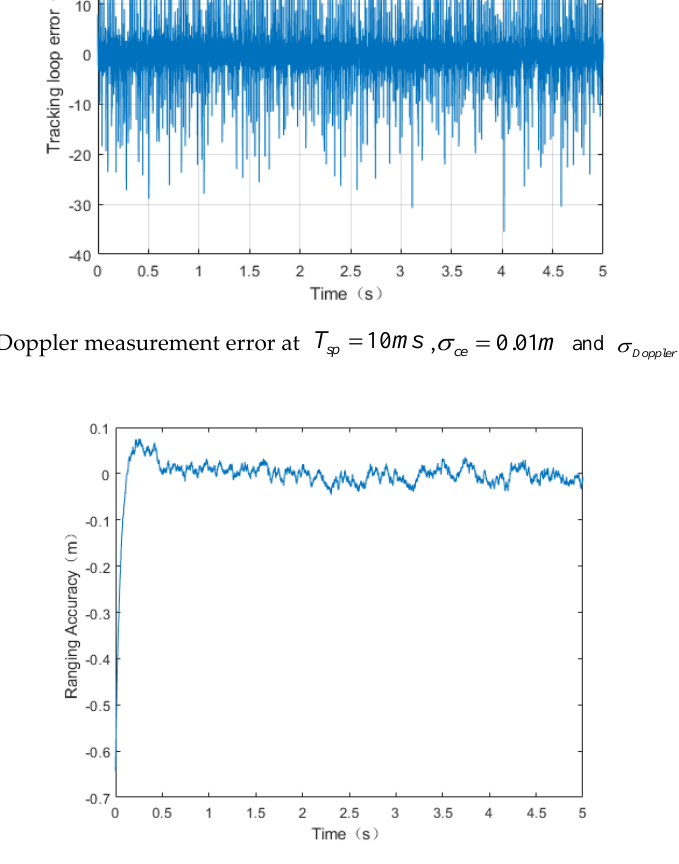
( c ) The pseudo-range measurement result at Figure A1. The measurement results at aircraft scenario, CNR = 60 dBHz. Figure A1. The measurement results at aircraft scenario, CNR = 60